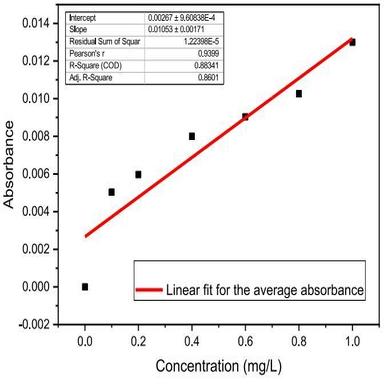
Calibration curve of the standard solutions.